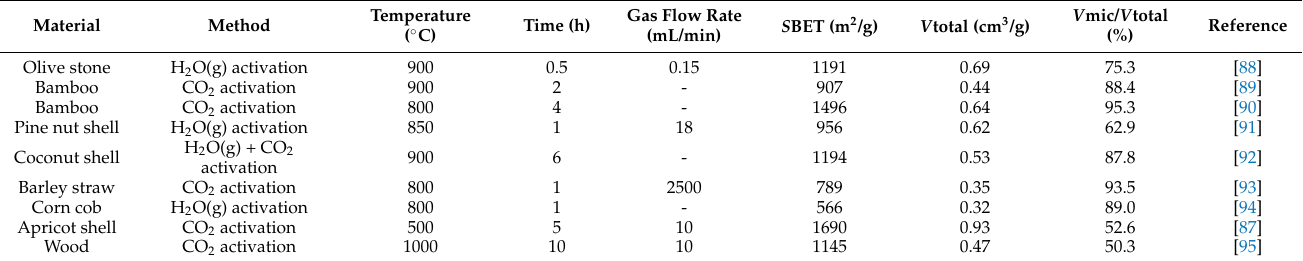
Table 2. Preparation of plant-derived carbon materials by physical